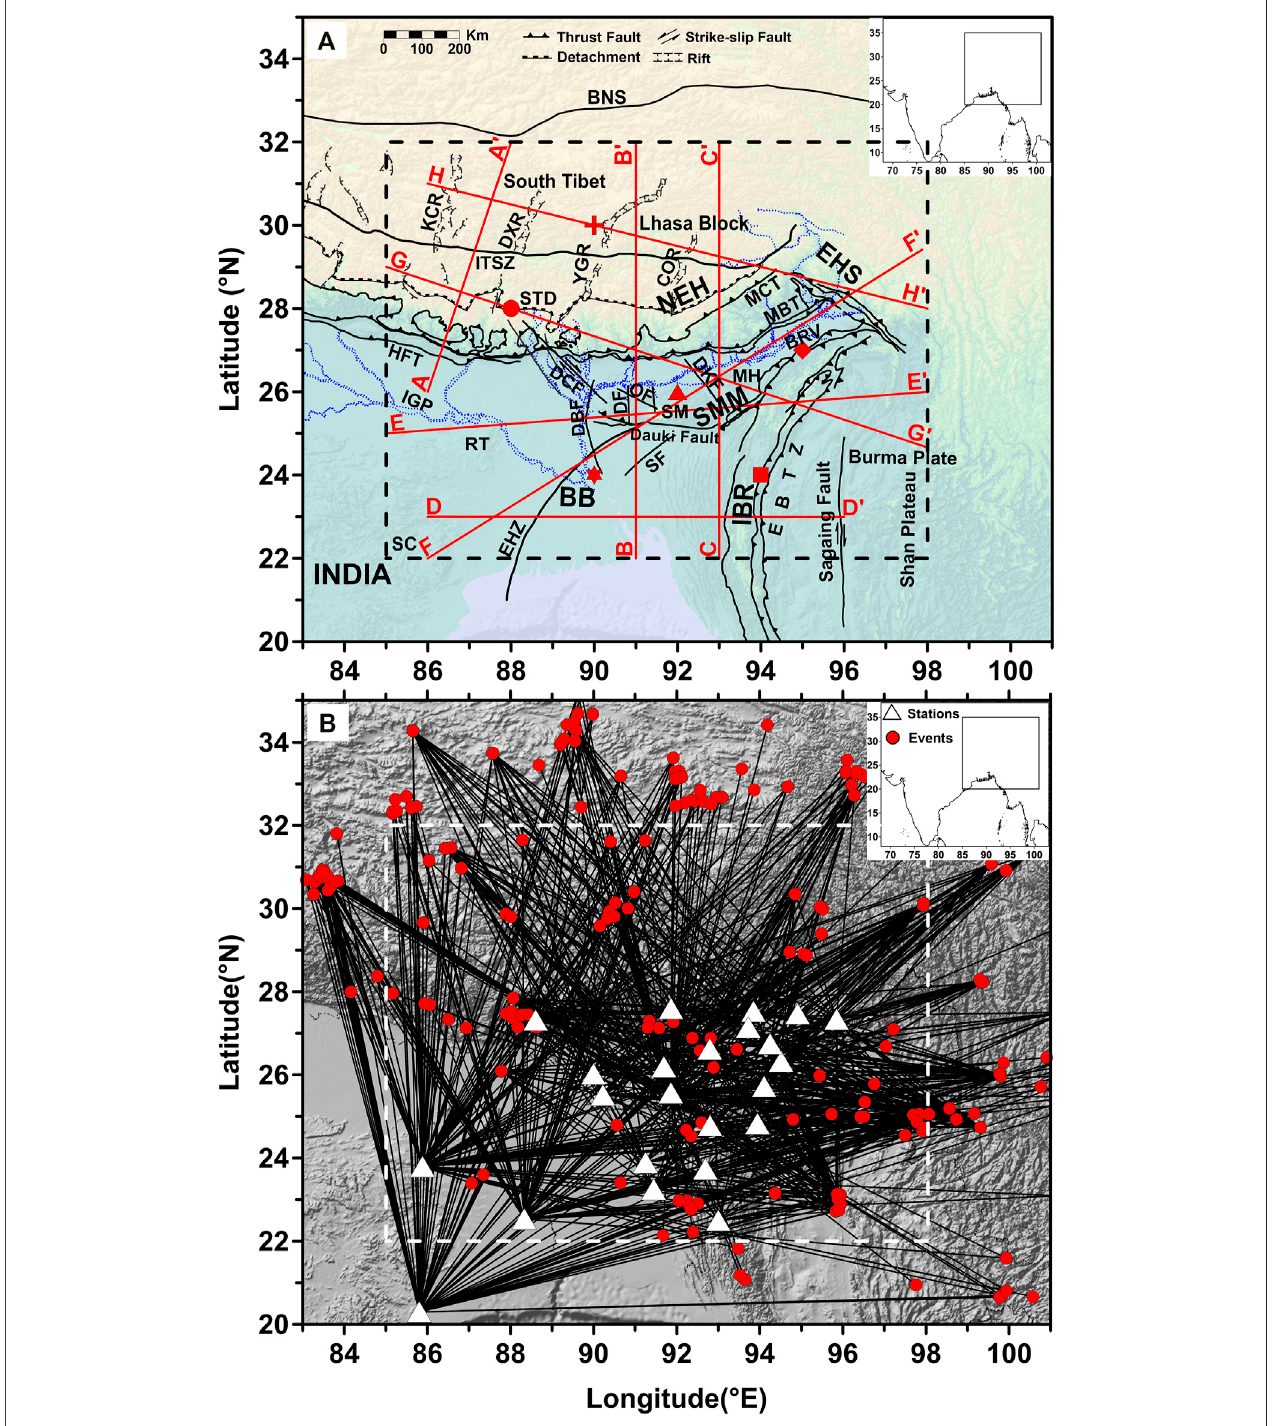
FIGURE 1 | Tectonic map of NE India and the surrounding area (GSI, 2000).Red symbols (shapes same as corresponding curves): location of six points for which Rayleighwavedispersion curvesareshownin Figure4 .Redlines:locationofpro fi lesforS-wavestructures( Figure8) .Rectangle(dashline)enclosestheareaforwhich results are used for interpretation. Abbreviations — IBR: Indo-Burma Ranges; NEH: Northeastern Himalaya; EHS: Eastern Himalayan Syntaxis; SMM: Shillong-Mikir Massif; SM: Shillong Massif; MH: Mikir Hills; BRV: Brahmaputra River Valley; BB: Bengal Basin; EBTZ: Eastern Boundary Thrust Zone; BNS: Bangong-Nujiang Suture;ITSZ:Indus-TsangpoSutureZone;STD:SouthernTibetanDetachment;MCT:MainCentralThrust;MBT:MainBoundaryThrust;HFT:HimalayanFrontalThrust; IGP: Indo-Gangetic Plain; SC: Singhbhum Craton; RT: Rajmahal Trap; SF: Sylhet fault; DBF: Dhubri fault; DKF: Dhansiri-Kopili fault; DF: Dudhnoi fault; EHZ: Eocence